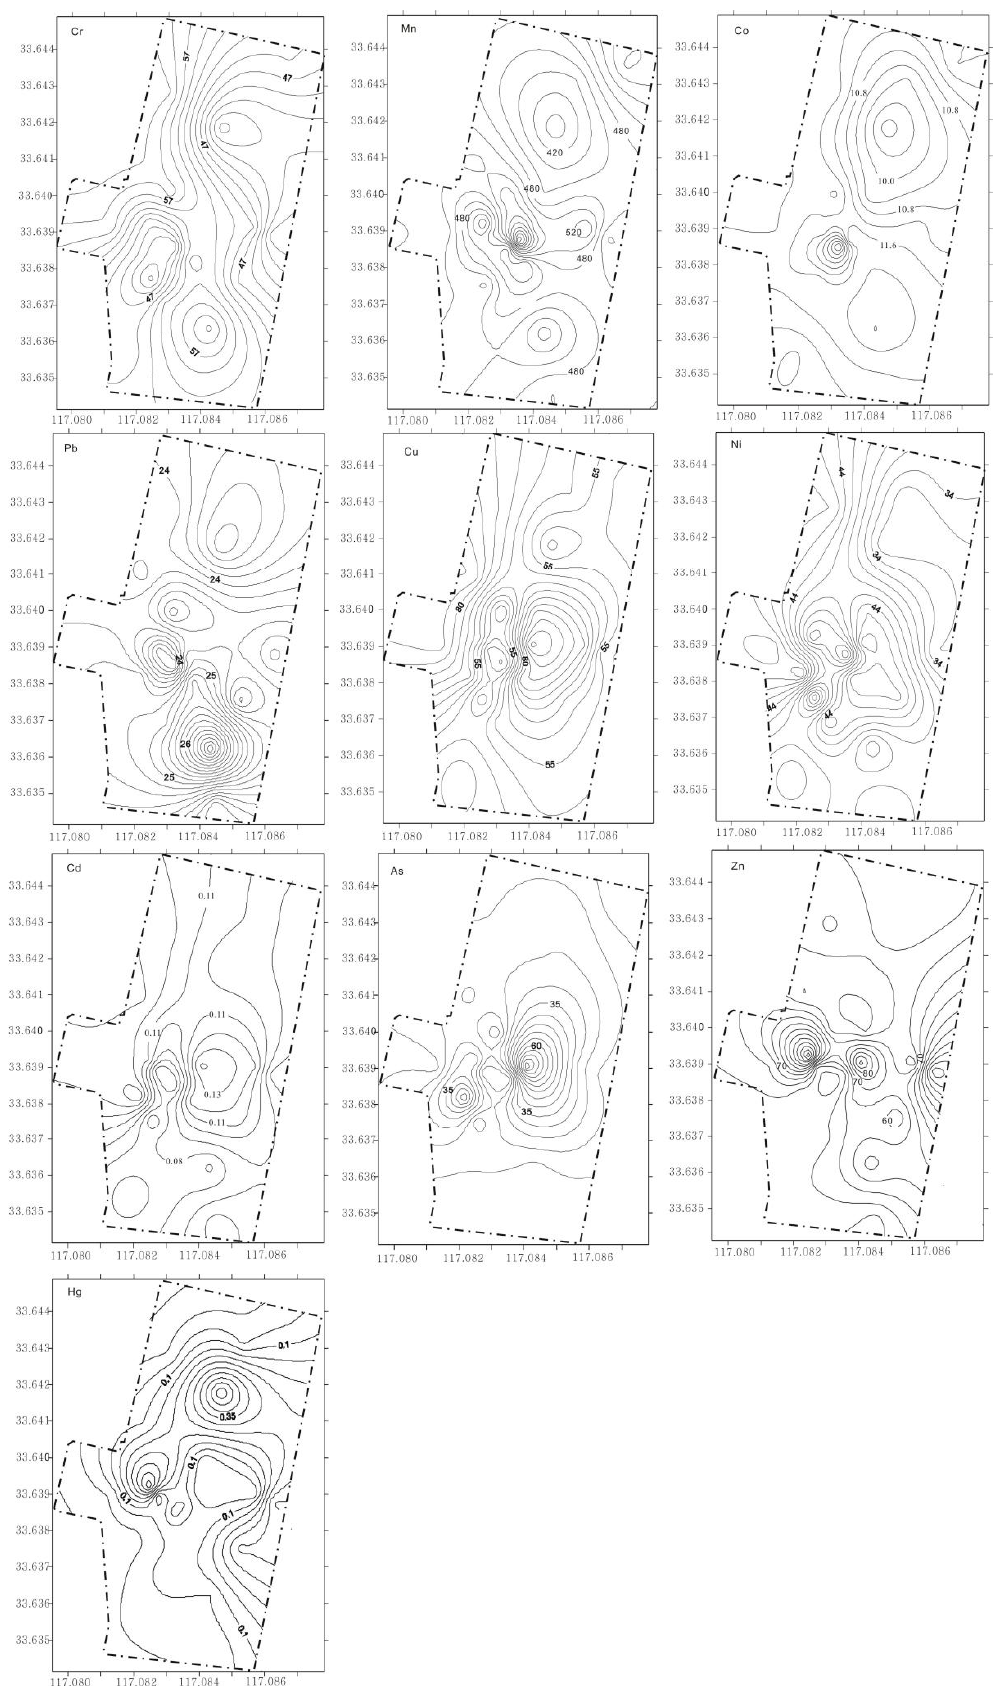
Figure 3. Contour map of spatial distribution of heavy metal in soils in the study area.